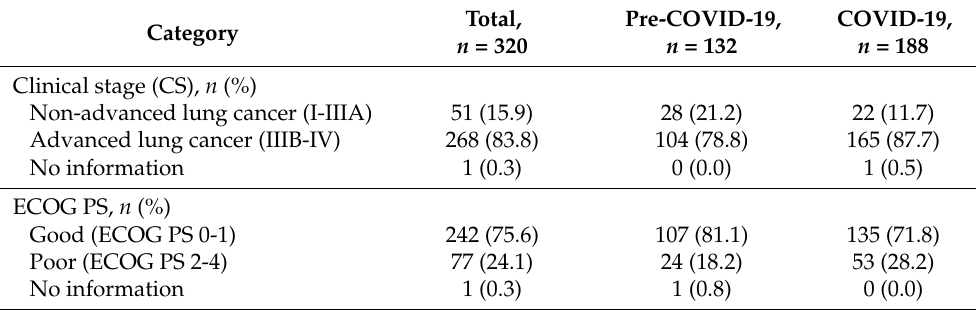
Table 4. Patients divided into categories by clinical stage and ECOG performance